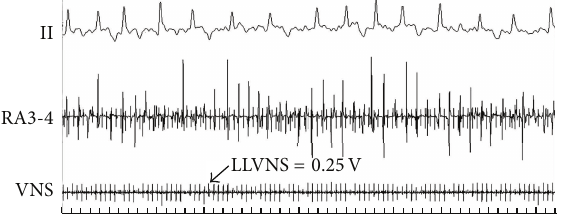
Figure 2: Low-level vagosympathetic nerve stimulation (LLVNS) during rapid atrial pacing (RAP). The voltage of LLVNS was 0.25 V (VNS channel). RAP was delivered at the LA site. RA3,4 channel recorded the signal of RAP and LLVNS.